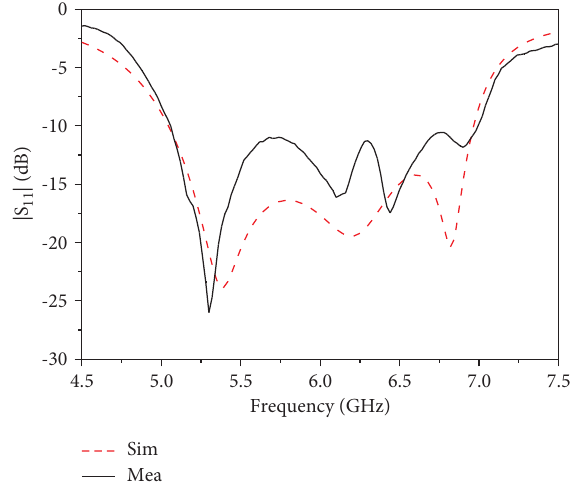
Figure 11: Simulated and measured | S